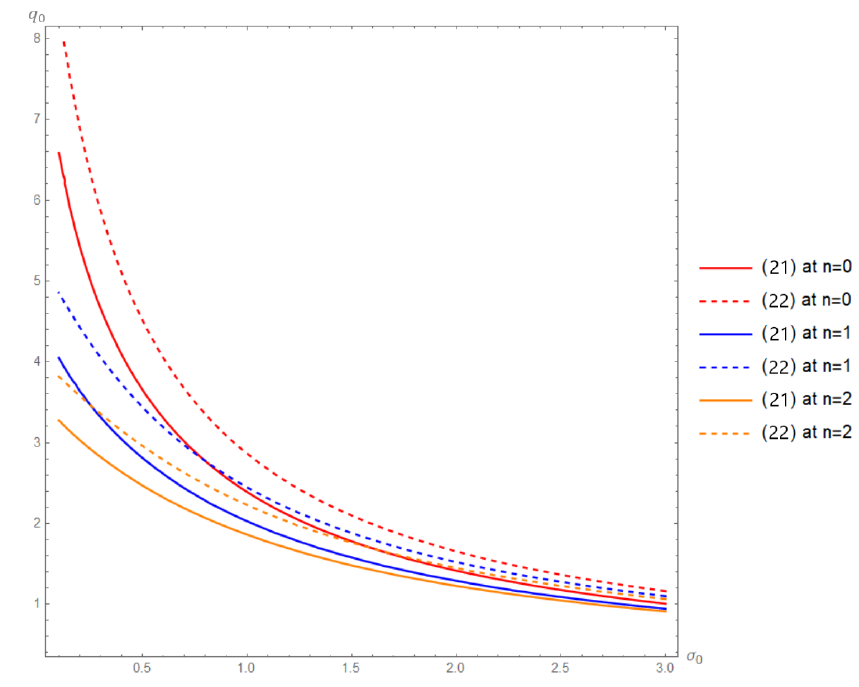
Figure 3. Comparison between criteria (21) and